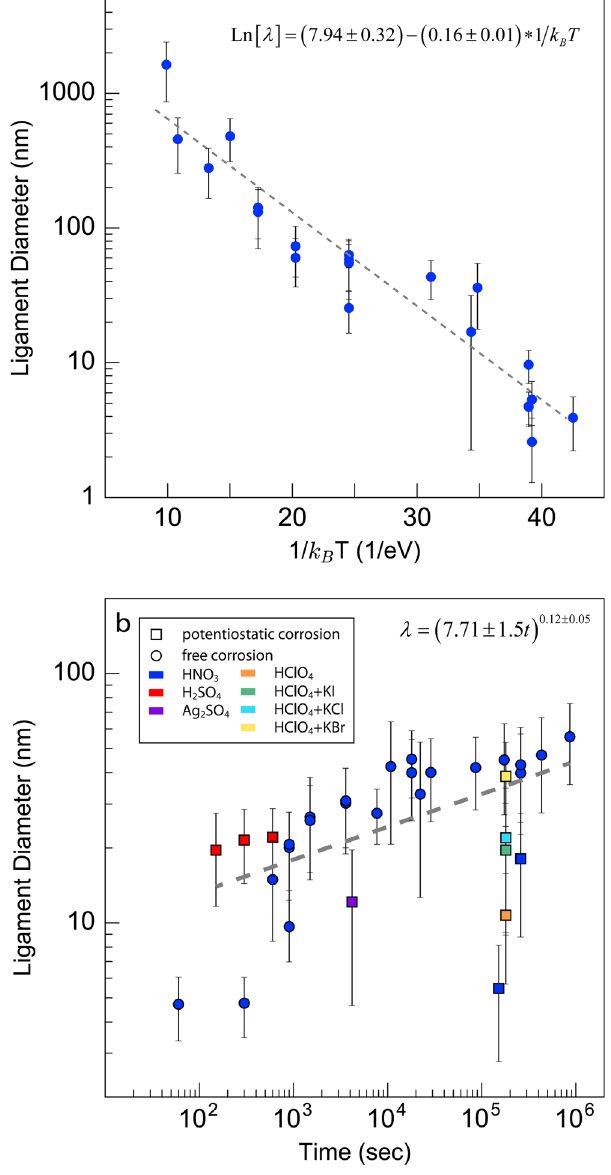
Figure 3. Coarsening of nanoporous gold. ( a ) Arrhenius plot of the ligament diameter after coarsening at elevated temperatures for short durations (600–1200 seconds). The dashed line is a linear least squares fit, whose slope equals − nE a and whose intercept equals Ln[( kD 0 )] n . ( b ) Ligament diameter versus time for room temperature coarsening over a wide range of times. The dashed line is a linear least squares fit, whose slope equals